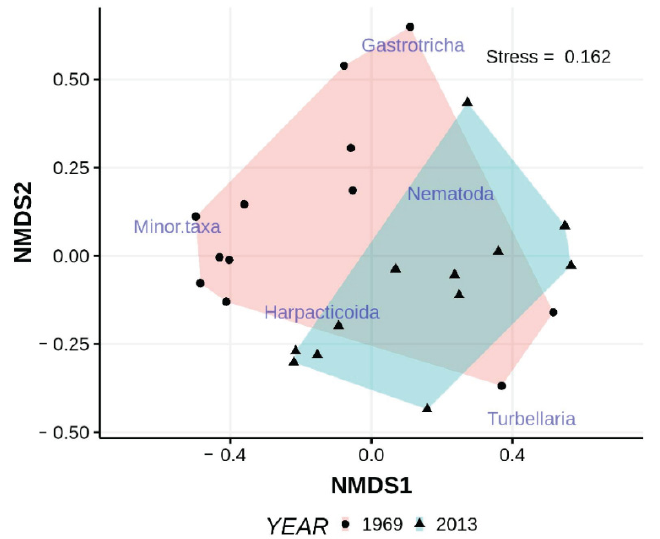
Figure 8. nMDS ordination of taxon abundances collected in samples from ISP beach intertidal in 1969 and 2013. “Minor” taxa here include tardigrades, archiannelids, juvenile bivalves, and juvenile polychaetes, all of which only occurred infrequently in low numbers. Non-metric scales serve to ease visual estimation of dissimilarity distances but are not associated with any specific units.